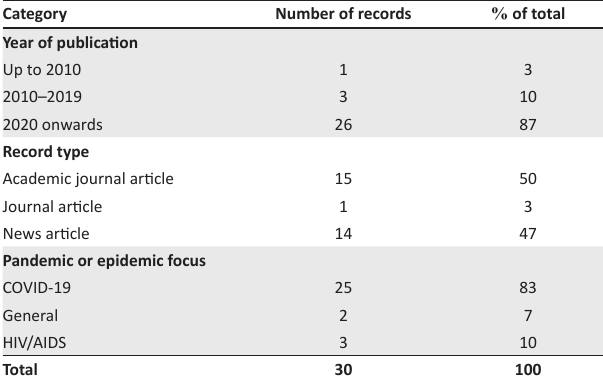
TABLE 1: Characteristics of records on sustainability elements of companies that are affected by